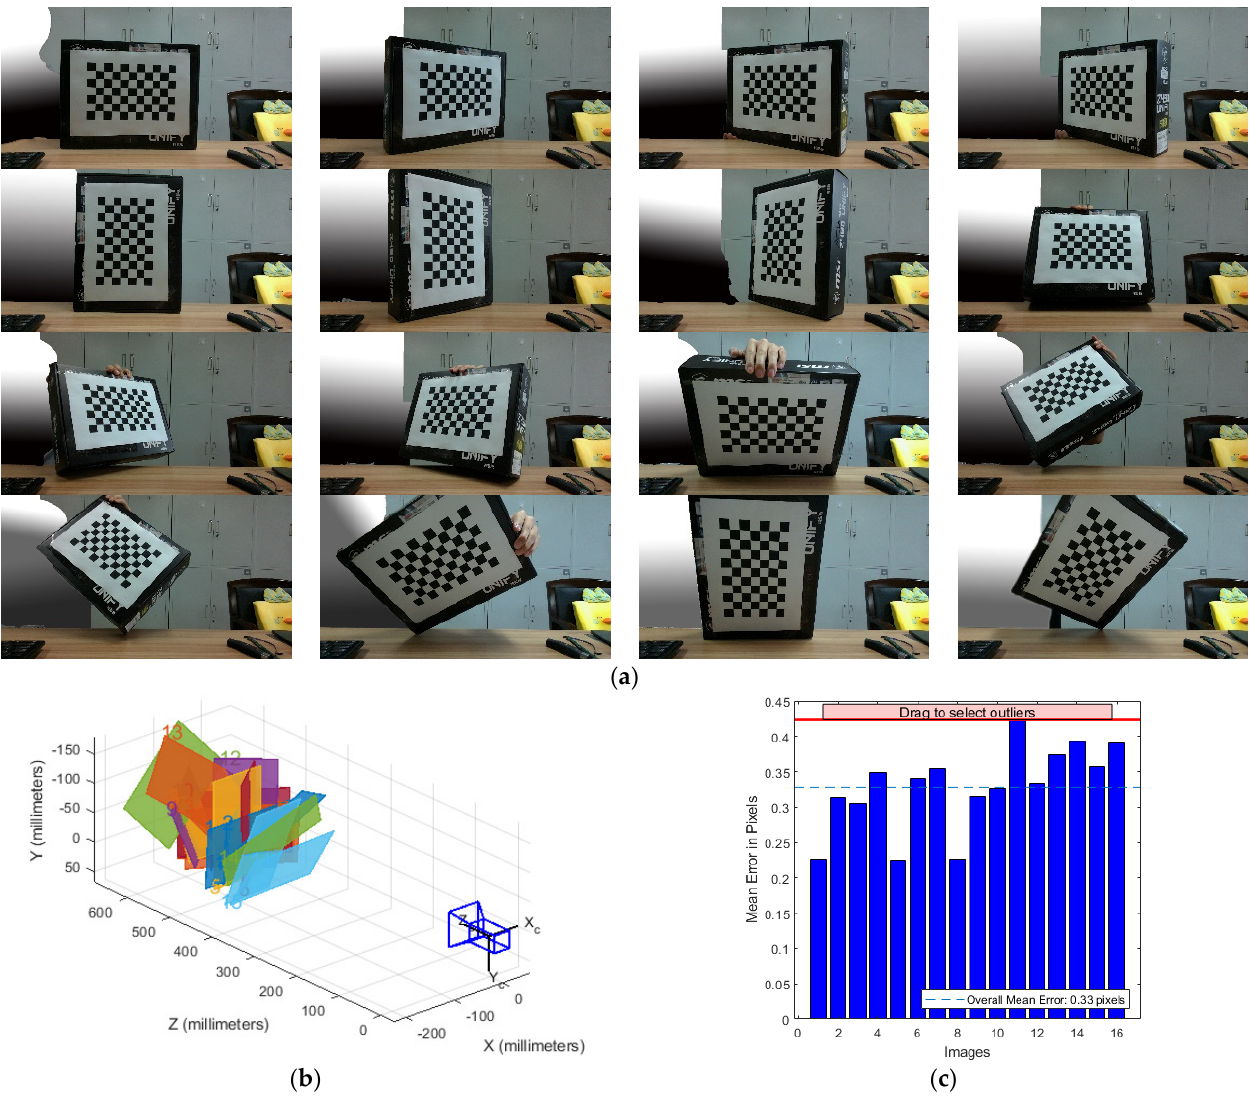
Figure 7. Monocular camera calibration: ( a ) pictures used for calibration; ( b ) position of checkerboard grid and camera; ( c ) error of pictures used for calibration. Table 3. Results of the monocular camera